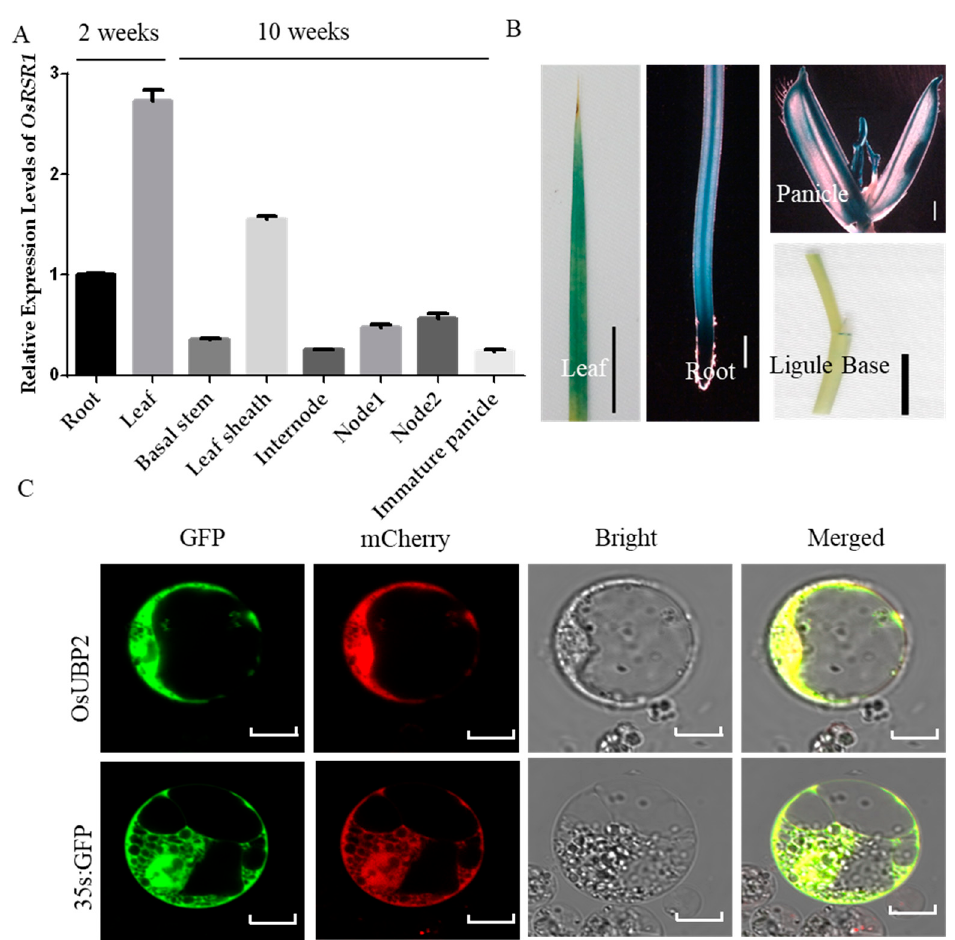
Figure 7. Expression pattern and subcellular location of OsUBP2. ( A ) Relative expression level of OsUBP2 in various organs at different growth stages. Error bars represent + SD ( n = 3). ( B ) β -glucuronidase (GUS) staining of pOsUBP2::GUS transgenic plants. Scale Bar = 2 cm in Leaf, Root and Ligule Base; Scale Bar = 0.2 cm in Panicle. ( C ) Subcellular localization of the OsUBP2 protein. Scale Bar = 20 μ m. White: white light channel; Merged: image color merged channel.